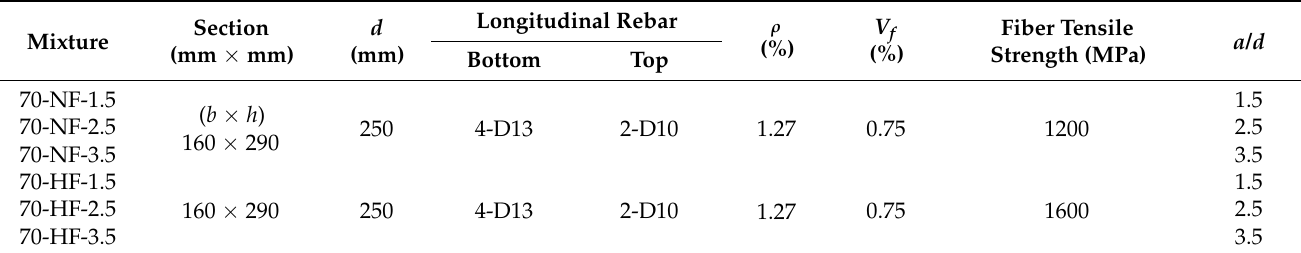
Table 1. Mixture Specimens and Test